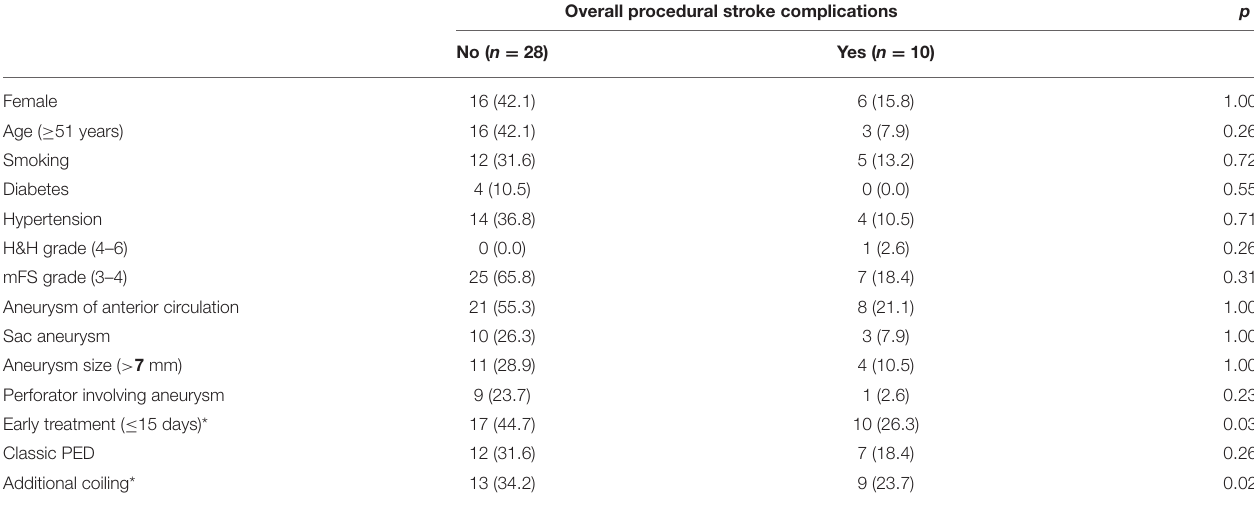
TABLE 3 | Factors associated with overall procedure-related stroke during